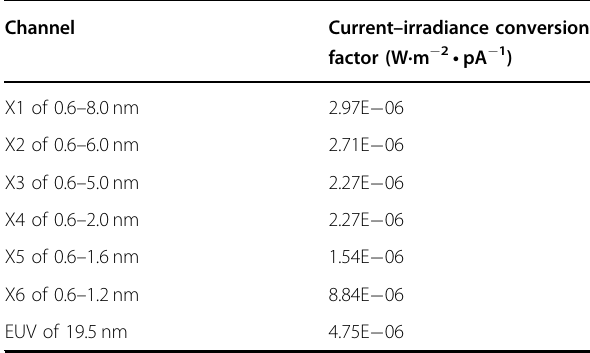
Table 3 Current-irradiance conversion factors of the X-ray and EUV sensor Channel